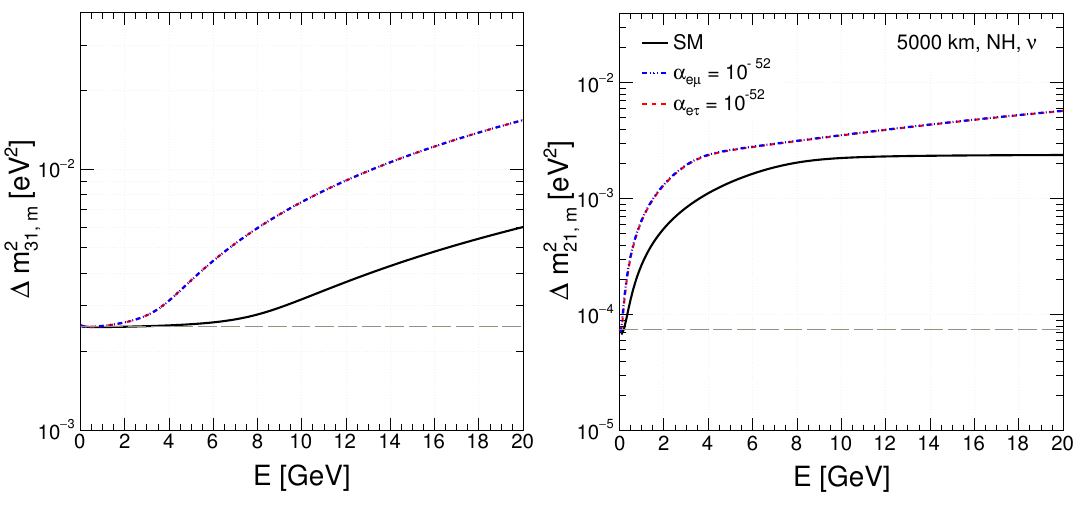
( (cid:17) m 2 (cid:0) m 2 , left panel) and (cid:1) m 2 ( (cid:17) m 2 (cid:0) m 2 , 31 ;m 3 ;m 1 ;m 21 ;m 2 ;m 1 ;m for L =5000 km and NH. We e(cid:22)=e(cid:28)